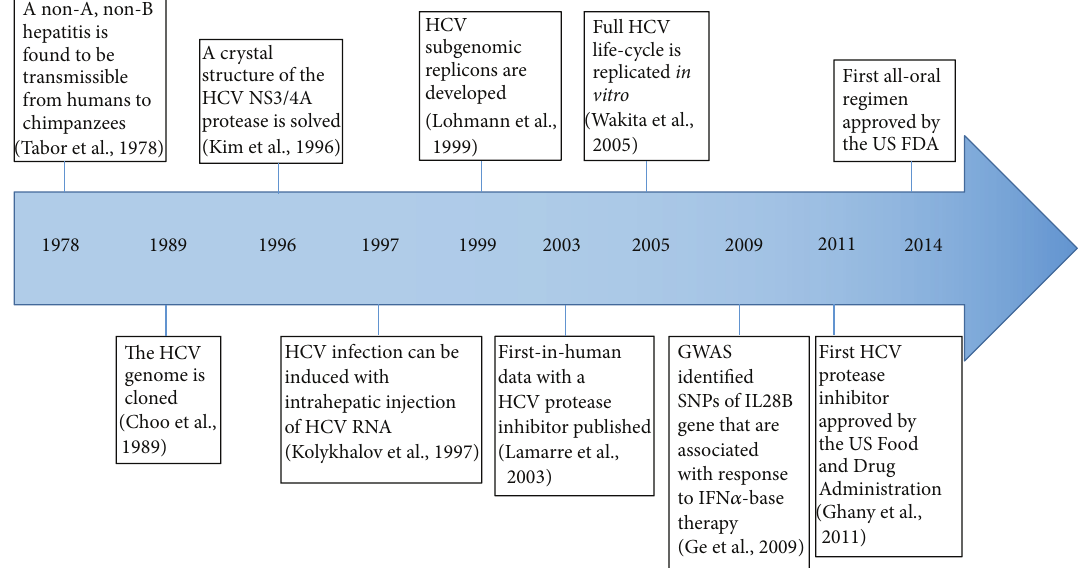
Figure 1: Timeline | Key discoveries in the basic science of